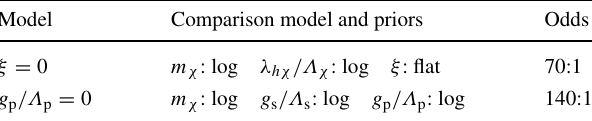
Table 8 Odds ratios for CP violation for the singlet Majorana fermion Higgs portal model. Here the odds ratios are those against a pure CP- even Higgs portal coupling, as compared to two different parametrisa- tions (and thus priors) of the model in which the CP nature of the Higgs portal can vary freely